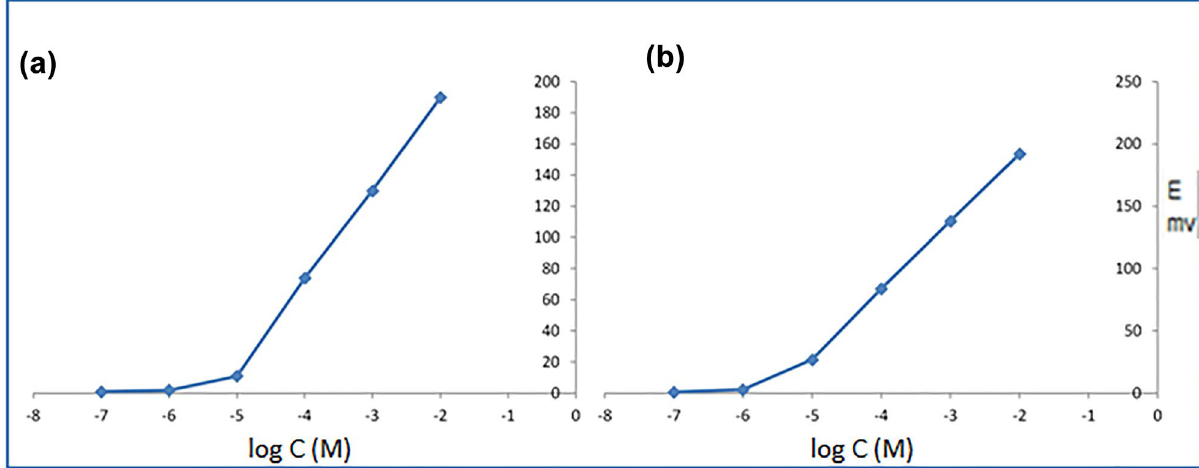
Figure 1. Profile of the potential in mV against log concentration of PALO at pH 5.0 for ( a ) ionophore-free sensor and ( b ) ionophore-doped sensor.